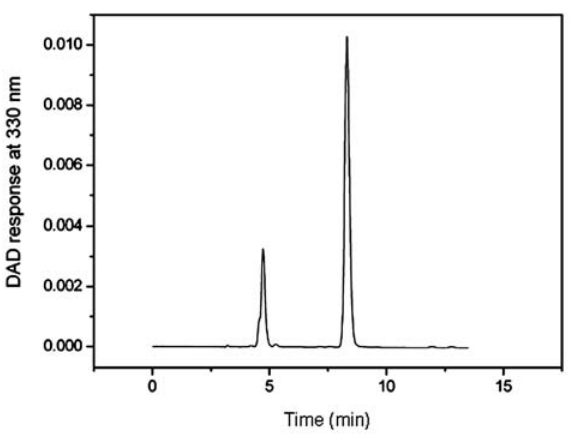
Fig . 4. – Typical chromatogram of cell extracts of the diatom Tha- lassiosira sp.: 1) Shinorine, 2) Porphyra-334. Detection at 330 nm